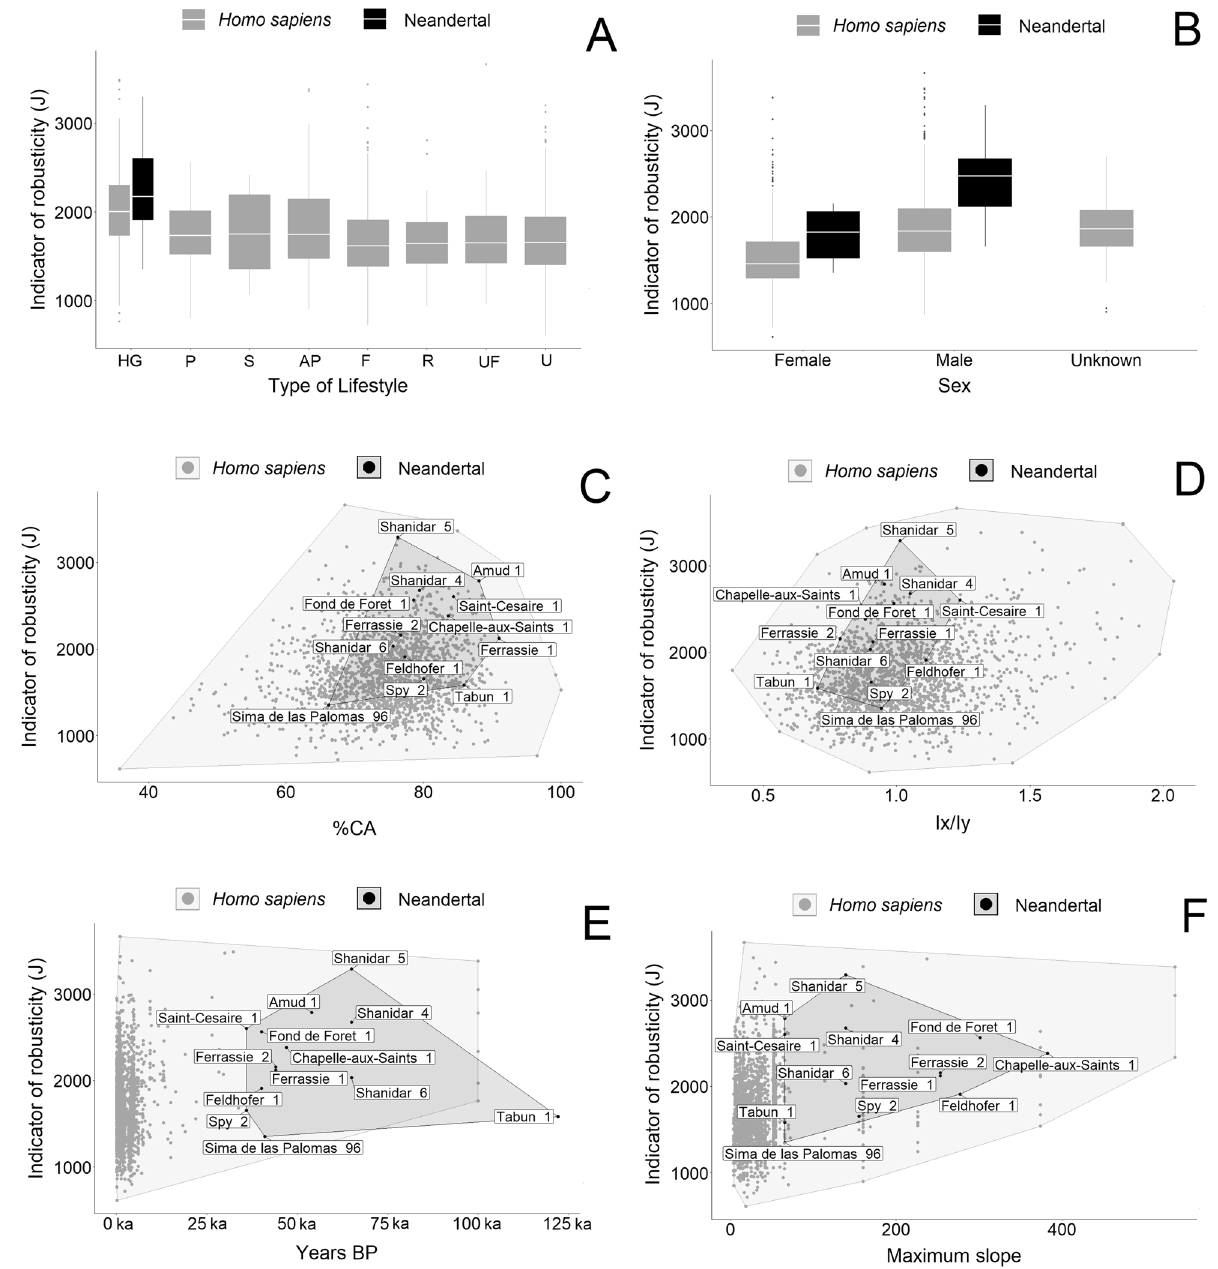
Figure 1. A graphic representation of the association between the standardized indicator of robusticity (size- adjusted J) and analyzed predictors in a cross-section of the femur. ( A ) Standardized indicator of robusticity (size-adjusted J) according to type of lifestyle. ( B ) Standardized indicator of robusticity (size-adjusted J) according to sex. ( C ) Association between standardized indicator of robusticity (size-adjusted J) and %CA. ( D ) Association between standardized indicator of robusticity (size-adjusted J) and Ix/Iy. ( E ) Distribution of standardized indicator of robusticity (size-adjusted J) during the chronological periods. ( F ) Association between standardized indicator of robusticity (size-adjusted J) and maximum slope of the terrain. HG hunting-gathering, P pastoralism, S seminomadic, AP agropastoralism, F farming, R rural, UF urban/farming, U